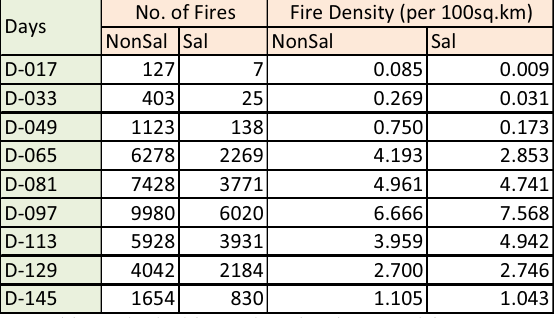
Table 2: Fire incidences in Sal and Non Sal forest